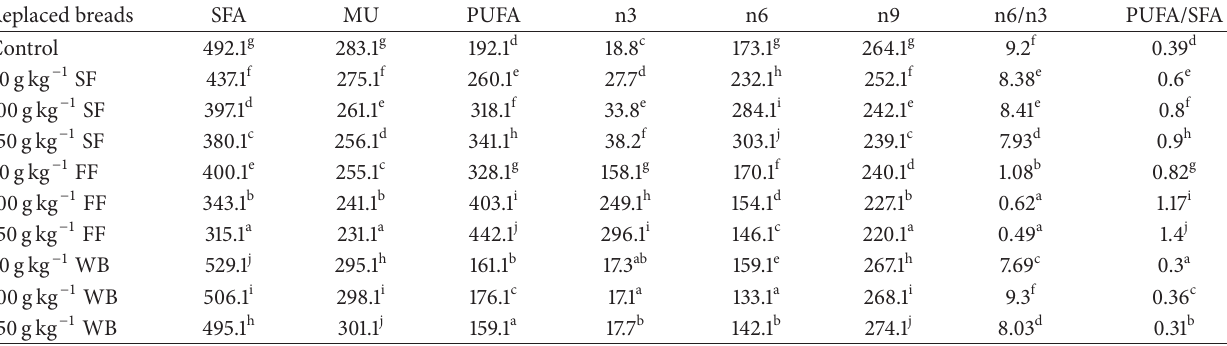
n3: fatty acids of the n3 family, n6: fatty acids of the n6 family, n9: fatty acids of the n9 family, n6/n3: relationship between fatty acids of series n6 and n3, WF: wheat flour, SF: soybean flour, FF: flaxseed flour, and WB: wheat